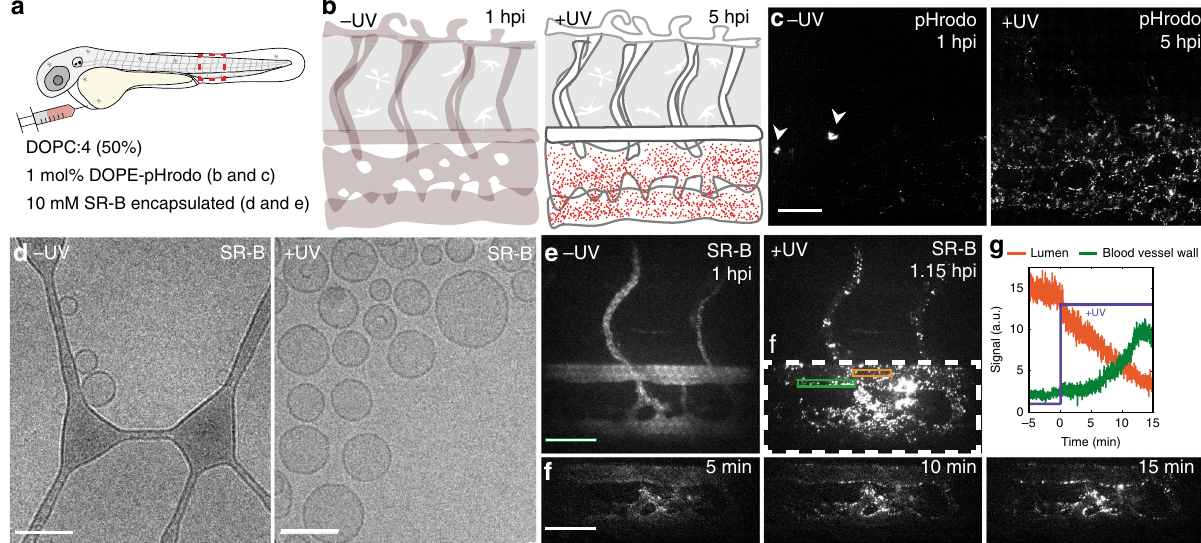
Fig. 7 Cellular fate of DOPC:4 → 3 liposomes and their encapsulated payloads. a , b Schematics showing the site of microinjection within a 2 dpf embryo and the evolving fl uorescence of pHrodo-containing DOPC: 4 → 3 liposomes within the tail region of a wildtype (AB/TL) embryonic zebra fi sh, over time. The fl uorescence intensity of pHrodo increases >100-fold in mildly acidic environments (e.g. late endosomes/lysosomes, pH < 6) and is, therefore, particularly apparent within SECs — cells with exceptionally high lysosomal activity. c Tissue level views of evolving pHrodo-associated fl uorescence over time either in the absence of UV irradiation and following in situ UV irradiation (15 min, 370 ± 7 nm, 2.4 J cm − 2 ). In the absence of UV irradiation, pHrodo- associated fl uorescence is observed within a small number of cells within the CHT of the embryo (white arrowheads). Liposomes contained 1 mol% DOPE- pHrodo for visualisation. Scale bar: 50 μ m. d CryoTEM images of SR-B fi lled, DOPC: 4 liposomes before and after in situ irradiation (15 min, 370 ± 7